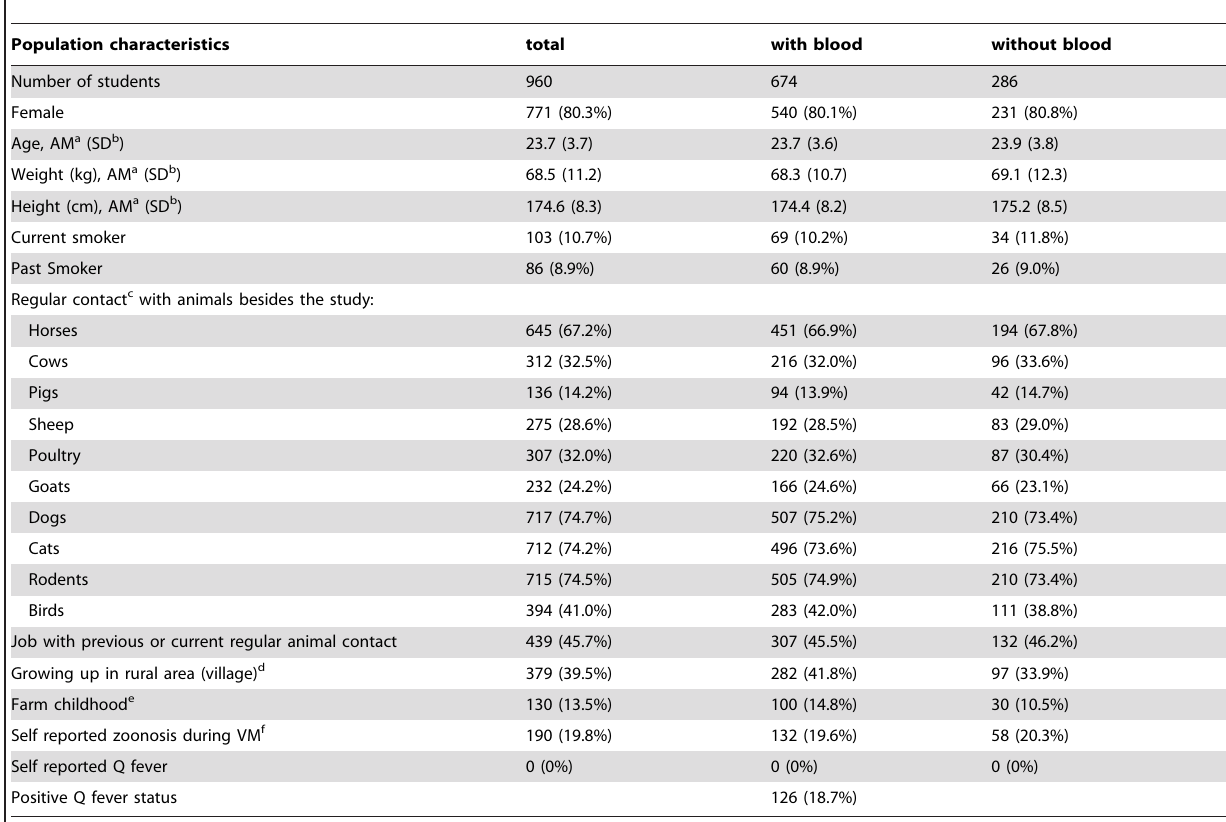
Table 1. Descriptive characteristics (n (%) or stated otherwise) of the total study population and those who did and did not provide a blood